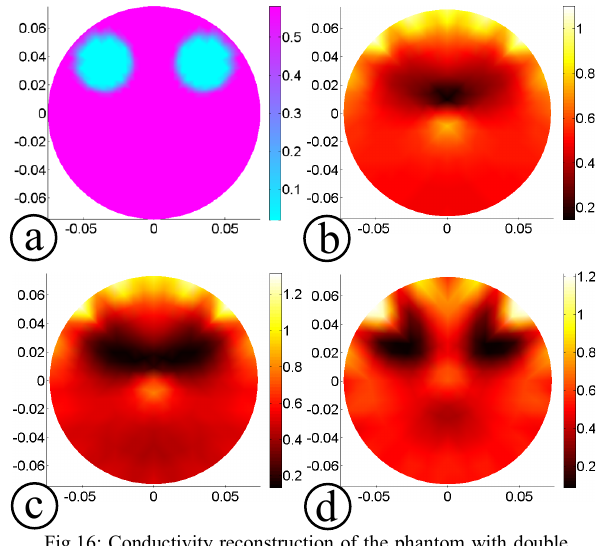
Fig.1 6: Conductivity reconstruction of the phantom with double inhomogeneity (D = 40 mm, L = 50.0 mm) near electrode No.-3 and 7 ( λ = 0.0011): (a) original object, (b) image with STR, (c) image with LMR, (d) image with BMMR.